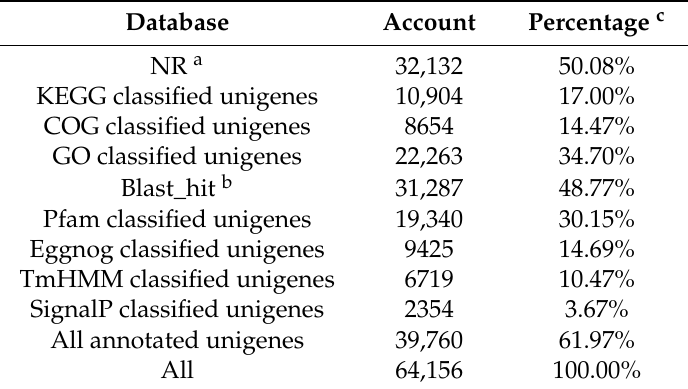
Table 3. Statistics of annotations of assembled